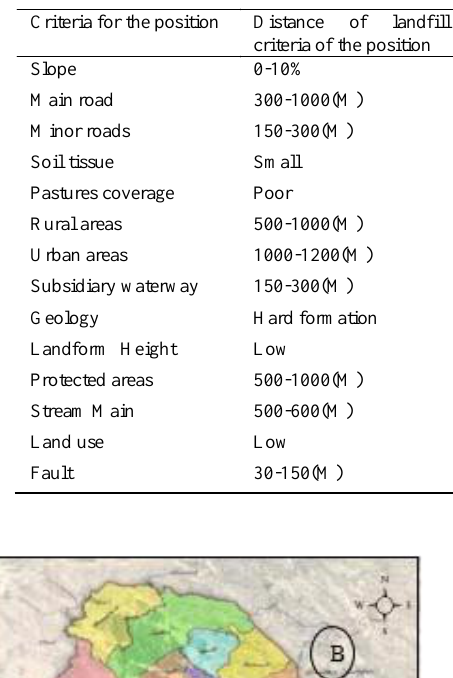
Table 1: Urban Waste Disposal Standards (Tasban et al .,